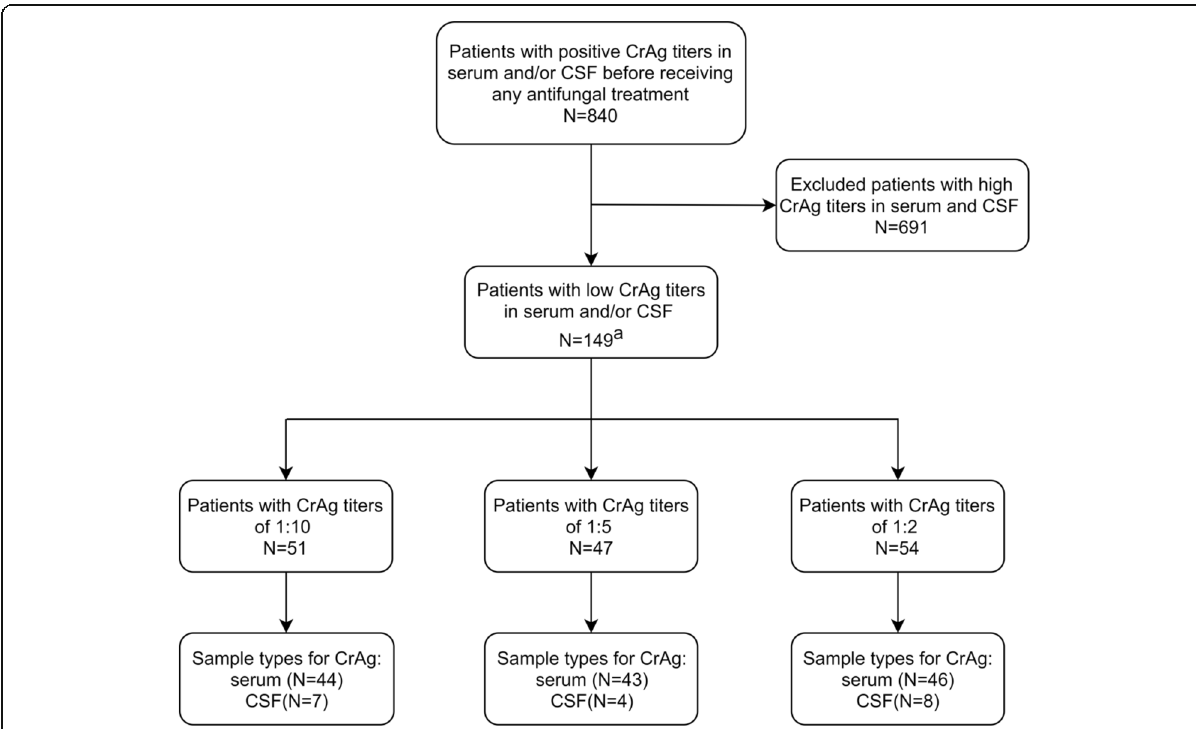
Fig. 1 Flow-chart to show individuals included and excluded from the study. a Three of the 149 patients were tested of low CrAg LFA titers in both serum and CSF, resulting in 152 samples included. Abbreviations: CrAg, cryptococcal antigen; CSF, cerebrospinal